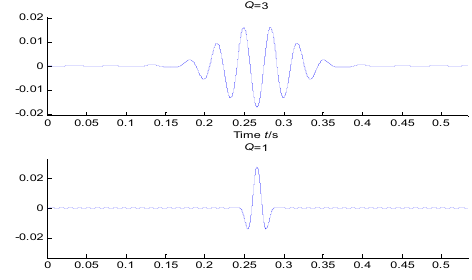
Figure 1. The time-domain diagram of low Q-factor and high Q-factor.